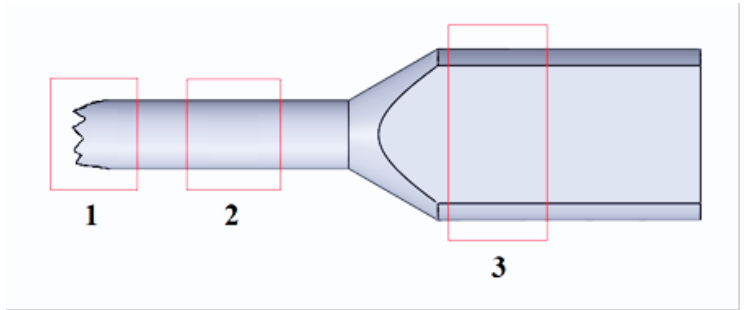
Figure 4. Scheme of places for measuring microhardness and studying microstructure: 1 — neck; 2 — deformable zone; 3 — non-deformable zone.